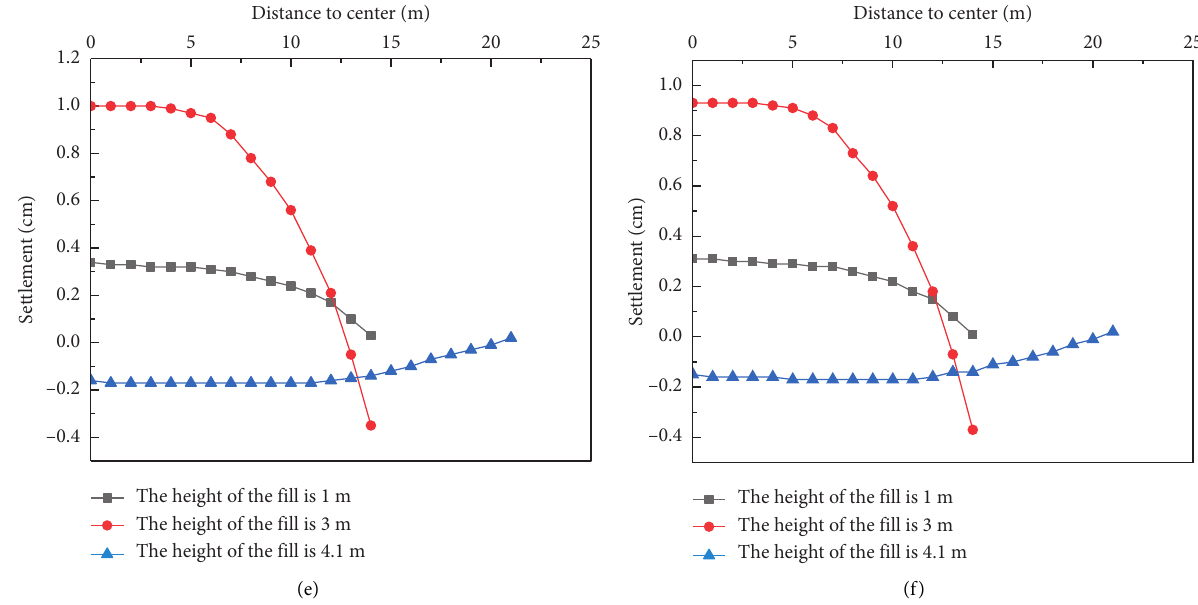
Figure 12: Layered settlement diagram of subgrade surface under different piles lengths. (a) Pile length under existing road slope equal to 4.7m. (b) Pile length under existing road slope equal to 7.2m. (c) Pile length under existing road slope equal to 9.7m. (d) Pile length under existing subgrade and new embankment equal to 4.7m. (e) Pile length under existing subgrade and new embankment equal to 7.2m. (f) Pile length under existing subgrade and new embankment equal to 9.7m.